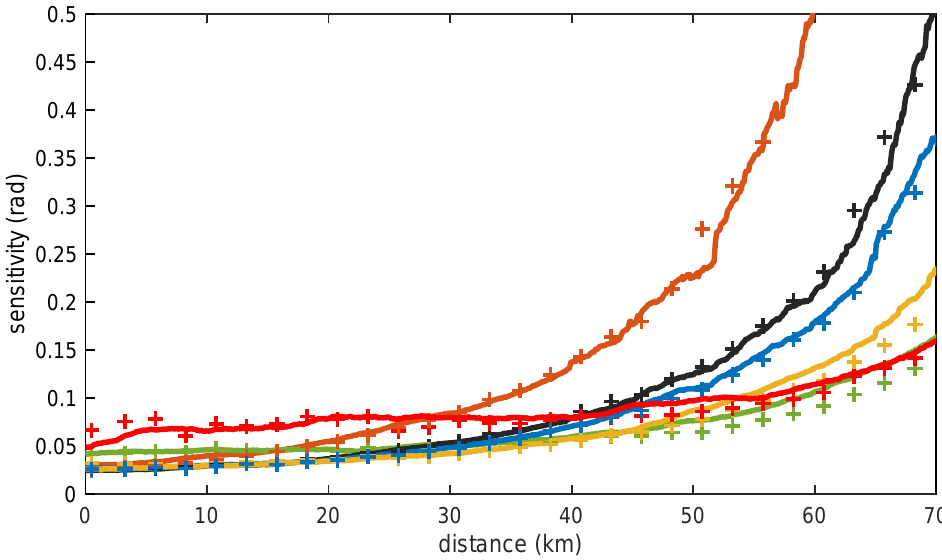
Figure 4. Sensitivity along a 70-km measurement range using LFM OPC with 2-m spatial resolution and 6-m gauge length for the 100-Hz linewidth NKT laser. Numerical (symbols), as well as experi- mental results (solid lines), are shown for different LFM pulse durations: 1-µs (dark orange); 3-µs (black); 4-µs (blue); 7-µs (orange); 15-µs (green); and 30-µs (red). A moving average was applied to smooth the